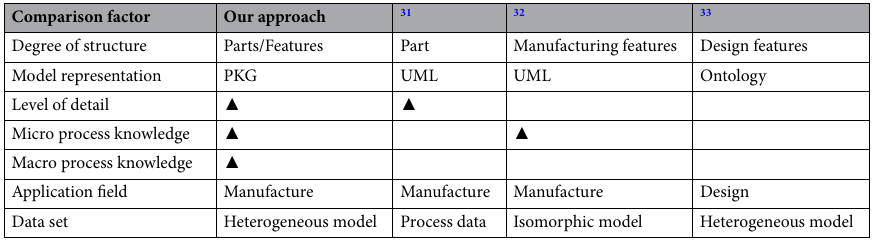
Table 1. Comparison of the method in this paper with other